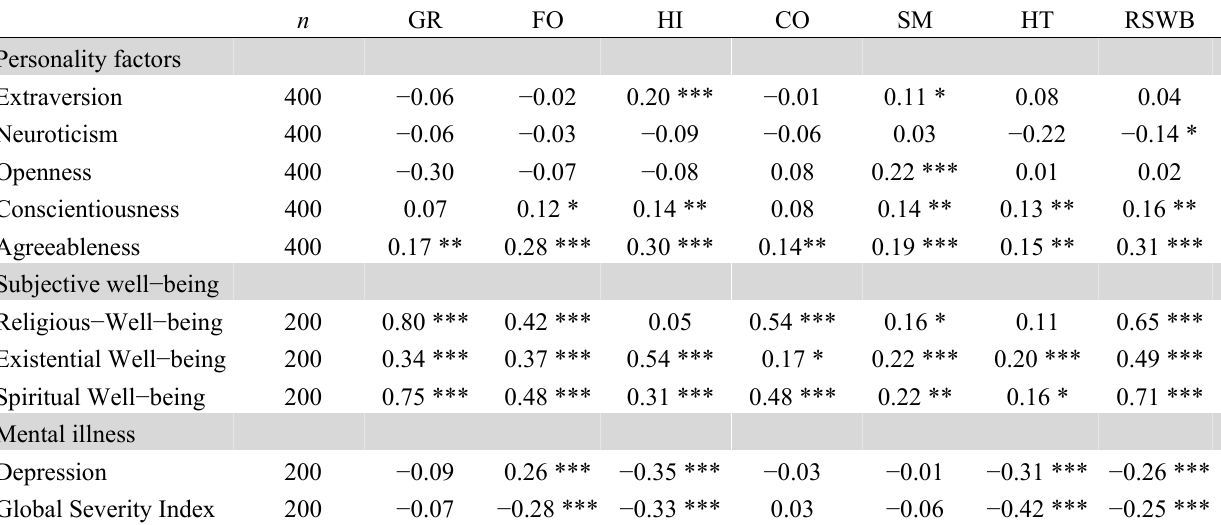
Table 3. Religious/Spiritual Well-being in relation to personality, subjective well-being and mental